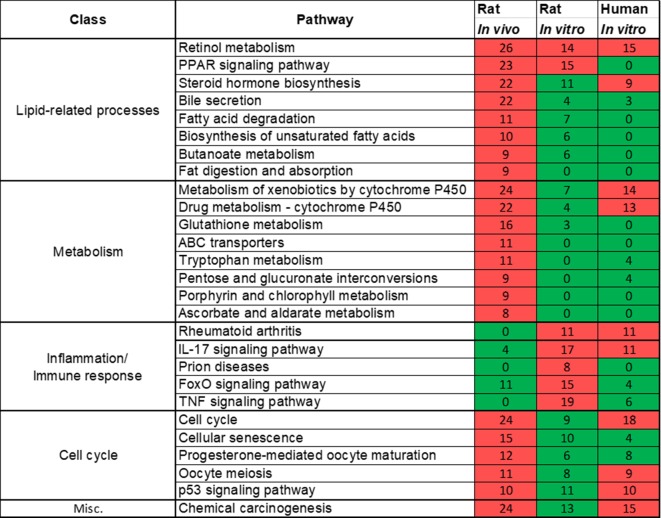
Pathways commonly enriched across three test systems (rat in vivo/vitro and human in vitro). A significantly enriched pathways is colored in red, otherwise it is colored in green. The number indicates the count of differentially expressed genes that mapped in that pathway. If a gene is differentially expressed for any chemical exposure and mapped to this pathway, they were counted together. Retinol metabolism pathway was commonly enriched in all three test systems.